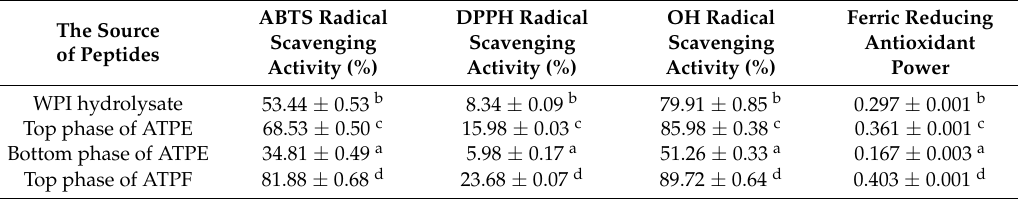
Table 1. Four antioxidant activity levels of peptides after